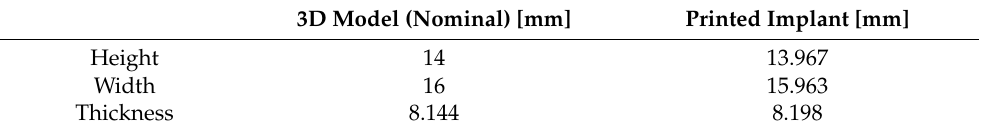
Table 3. Dimensional parameters of the CAD model (reference value) vs. dimensional parameters of the printed implant.